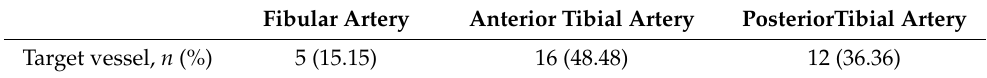
Table 2. Target vessel for atherectomy.